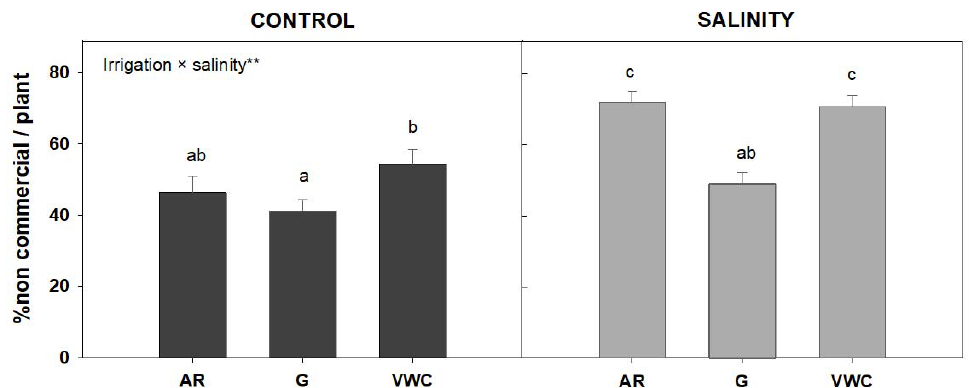
Figure 7. Average percentage of non-commercial yield (% non-commercial yield/plant), according to water quality and the irrigation used. The error bar indicates the standard error of the mean (n = 24). Top left in this Figure means: ** indicates significant differences at p < 0.05 between irrigation methods for each quality of water. Values with different letters are significantly different at 95%, according to Duncan’s multiple range test.